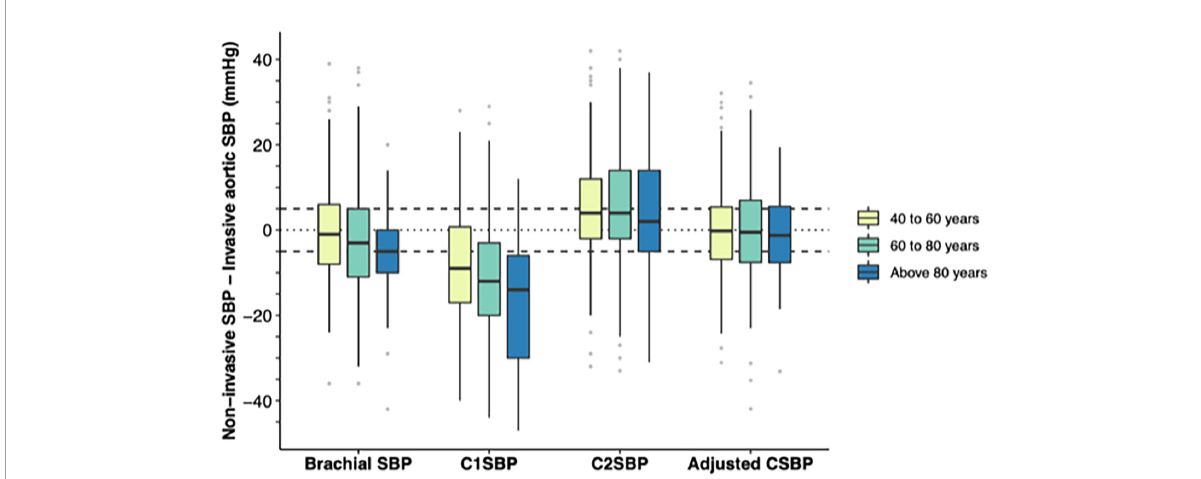
FIGURE2 Differences between brachial SBP/estimated central SBP and invasive aortic SBP by age before and after adjustment. The distribution of differences by age strata are displayed by boxplots before and adjustment (full model). The horizontal black line in the middle of each box indicates the median, the square extremities indicate the interquartile range, and the vertical black lines end at either the minimum (first quartile minus 1.5 times the interquartile range) or the maximum (third quartile plus 1.5 times the interquartile range). Gray dots indicate outliers. The full models include the age, sex, heart rate, estimated SBP amplification, pulse wave velocity, augmentation index at 75 bpm, reflection magnitude, height, weight, eGFR, active smoking, diabetes, and antihypertensive treatment. C1SBP, Type I calibrated central SBP; C2SBP, Type II calibrated central SBP; eGFR, estimated glomerular filtration rate; SBP, systolic blood pressure.